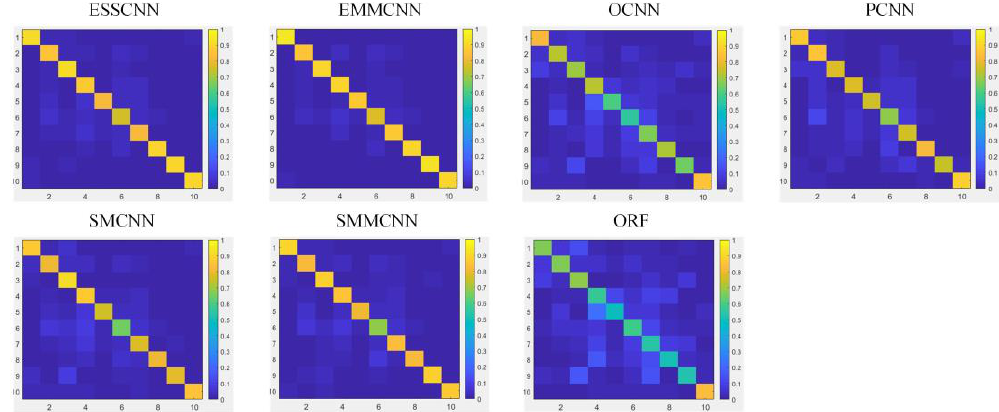
Figure 8. Confusion matrices of testing samples in the Beilun dataset for the ESSCNN, EMMCNN, OCNN, PCNN, SMCNN, SMMCNN, and ORF methods. The numbers 1 to 10 in horizontal and vertical axis denote the farmland, woodland, grassland, dense building, sparse building, road, impervious surface, facility land, vacant, and water classes, respectively. ESSCNN: extended topology-preserving segmentation (ETPS)-based single-scale and single-feature convolutional neural network (CNN); EMMCNN: ETPS-based multi-scale and multi-feature CNN; OCNN: object-based CNN; PCNN: patch-based CNN; SMCNN: simple linear iterative clustering (SLIC)-based multi-scale CNN; SMMCNN: SLIC-based multi-scale and multi-feature CNN; ORF: object-based random forest.